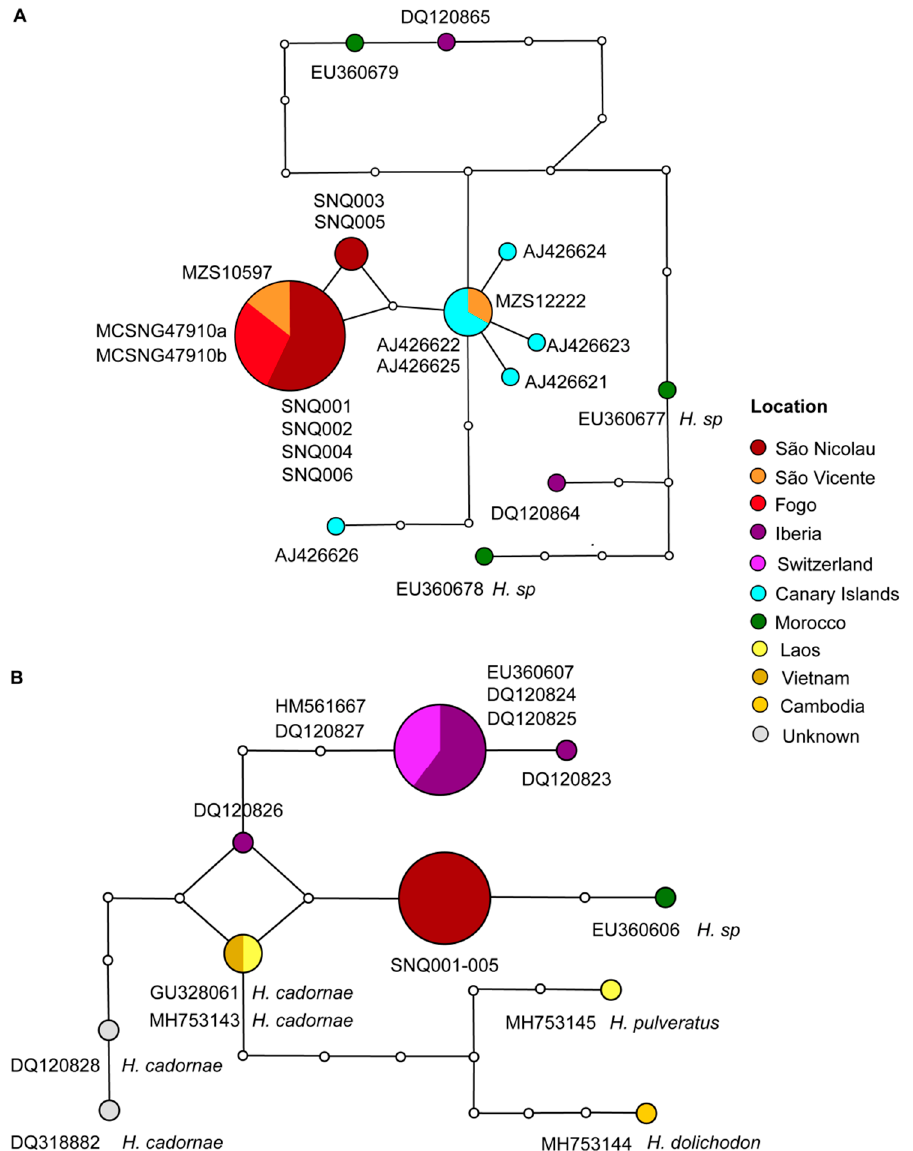
Figure 4. Parsimony networks including sequences similar to those of Hypsugo from Cabo Verde Islands. Network corresponding to the cyt b mtDNA ( A ) and RAG2 nDNA sequences variation ( B ). Lines represent mutational steps, circles indicate haplotypes, and dots show missing haplotypes. The size of the circle is proportional to the number of individuals, and different colors correspond to different locations. For further details on the samples, see Figure 1, Table S1 and S3.